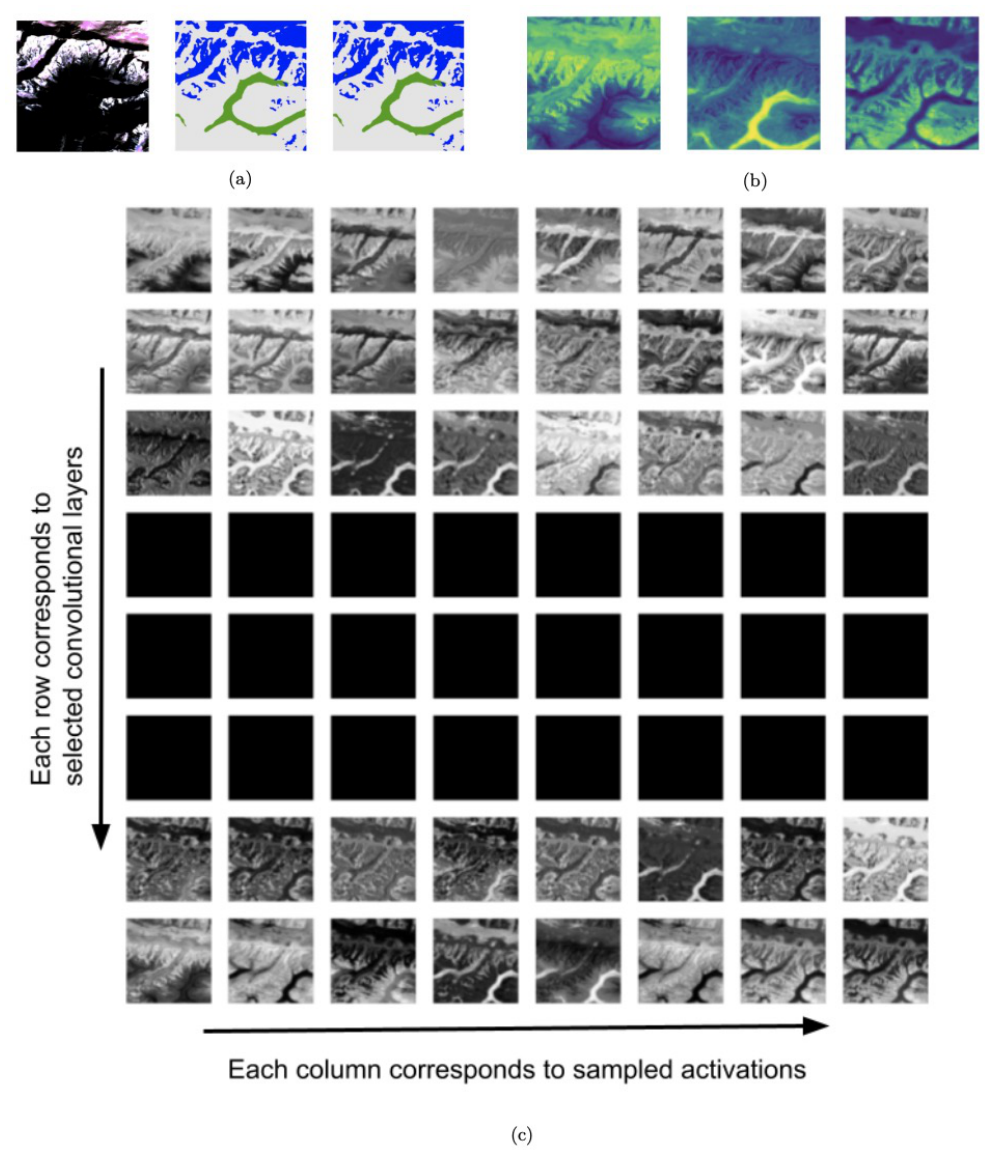
Figure 7. ( a ) Original figure, true labels and the prediction. Blue, green and gray represent clean-ice glaciers, debris-covered glaciers and background, respectively. ( b ) Visualization of the segmentation layer. The three panels represent clean ice, debris and background, respectively. ( c ) Activations of one satellite image across eight convolutional layers of the U-Net model. For each layer, we randomly plot eight activations in grayscale. Each row corresponds to different convolutional layers, and each column corresponds to different sampled activations. From the top to the bottom rows, they correspond to the first, third, fifth and seventh downsampling convolutional layers, the second middle convolutional layer (bottleneck), the first and third upsampling convolutional layers and the last pooling layer. We also annotate these layers in the model architecture diagram in Figure